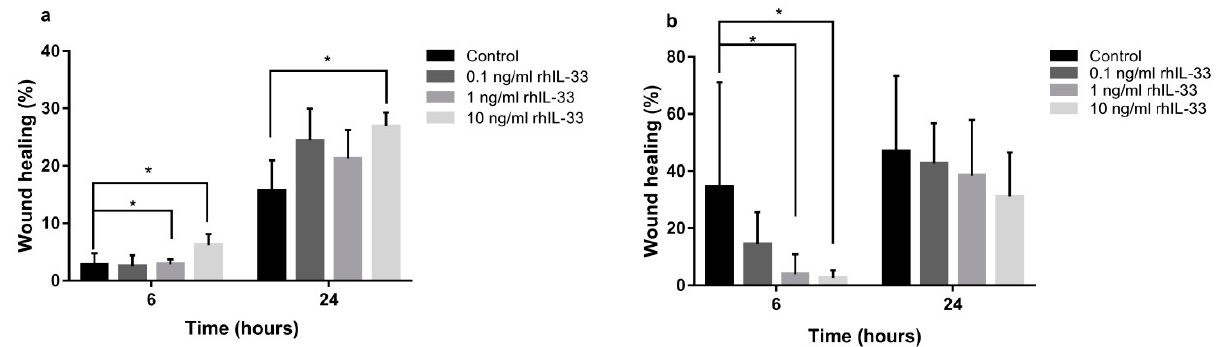
Figure 3. Administration of rhIL-33 for 6 and 24 h induced migration in the normal cell line (GES-1) ( a ), while migration was delayed in neoplastic cells (AGS) ( b ). Data are shown as mean ± SD. * p < 0.05.